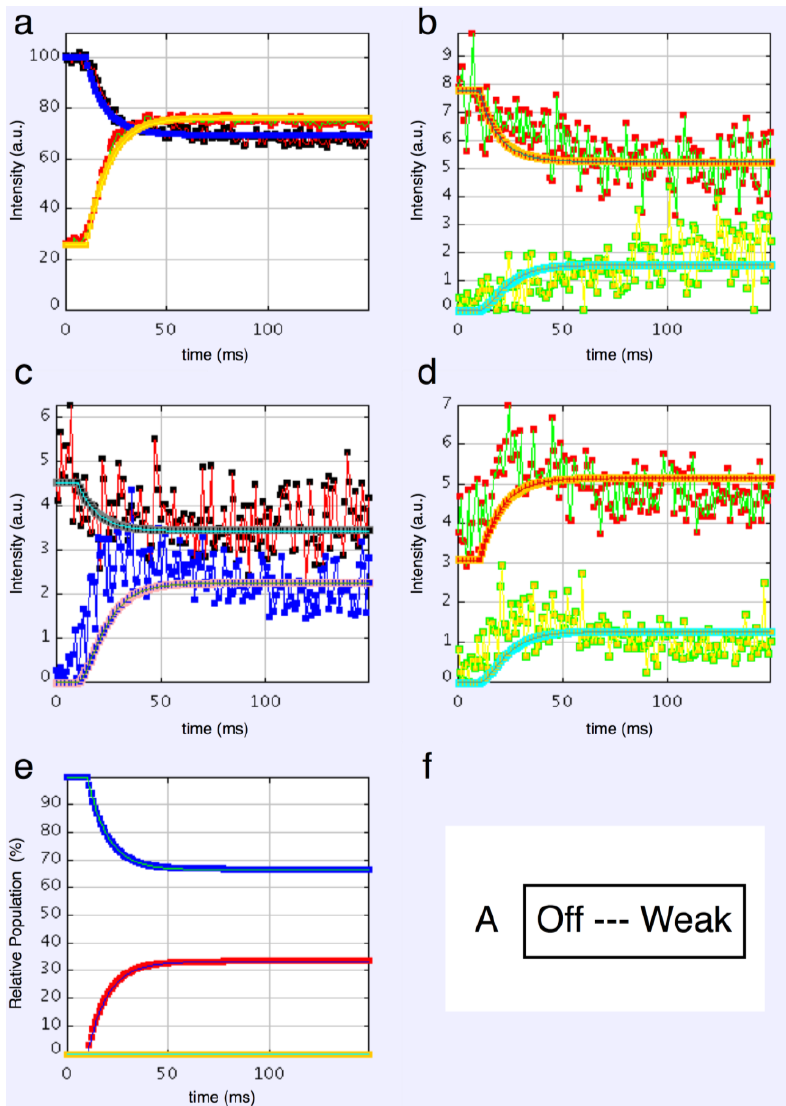
Figure 8. Plots from simulated annealing fits of the 2-state model (A in Figure 2b) to the observed equatorial time-courses in Figures 4 and 6, with SL control applied. The fit is reasonable (Chi = 1457), but there are clearly no overshoots in any of the time-courses. ( a ) Plot of the A(10) data, in black, and the fit, in blue; the A(11) data, in red, and the fit, in yellow. ( b ) Plot of the A(20), in red, and the fit, in orange; the A(40) data, in green, and the fit, in turquoise. ( c ) Plot of the A(21) data, in black, and the fit, in pale blue; the A(31) data, in bright blue, and the fit, in purple. ( d ) Plot of the A(30) data, in red, and the fit, in orange; the A(32) data, in green, and the fit, in turquoise. ( e ) Plot of the populations in the two states: off is blue, weak is red. The populations at the active plateau are 67% off and 33% weak (Table 4). ( f ) The two states in model A: off and weak.